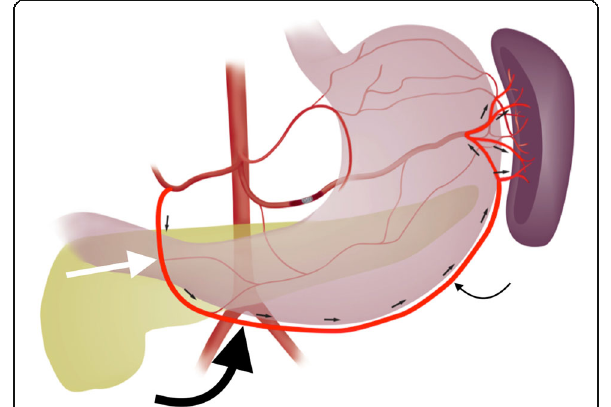
Fig. 6 Transradial splenic angiogram following splenic trauma. After proximal splenic artery embolization using coils (black star), flow from the proximal splenic artery (straight white arrow) to the distal splenic artery (curved white arrow) is maintained via dorsal pancreatic (straight thin black arrow) to transverse pancreatic (straight thick black arrow) to great pancreatic artery (curved black arrow)